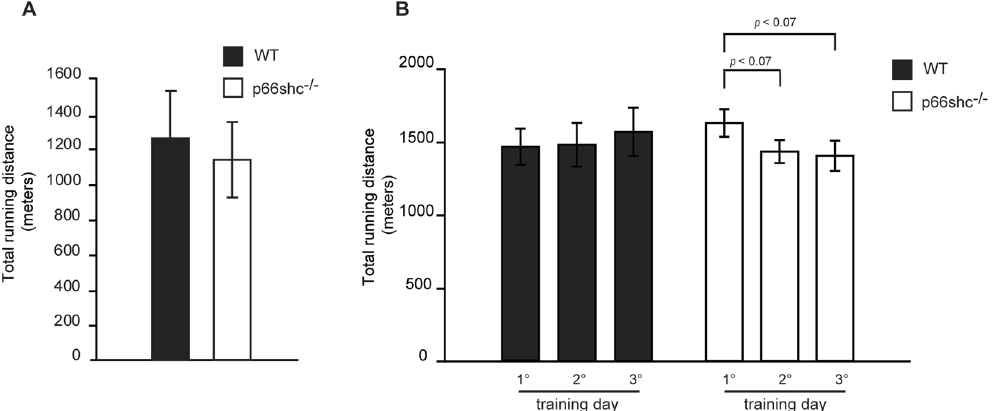
Figure 3. p66shc deletion negatively affects downhill exercise performance. ( A ) Mean maximal running distance of a single bout of run on a treadmill of wt and p66shc − / − mice. Data are presented as mean ± SEM (8 animals per group). ( B ) Mean maximal running distances after each of 3 days of downhill run on a treadmill of wt and p66shc − / − mice. p < 0.07, pairwise multiple comparison (Holm-Sidak method) of 5 animals per condition. Data are presented as mean ±